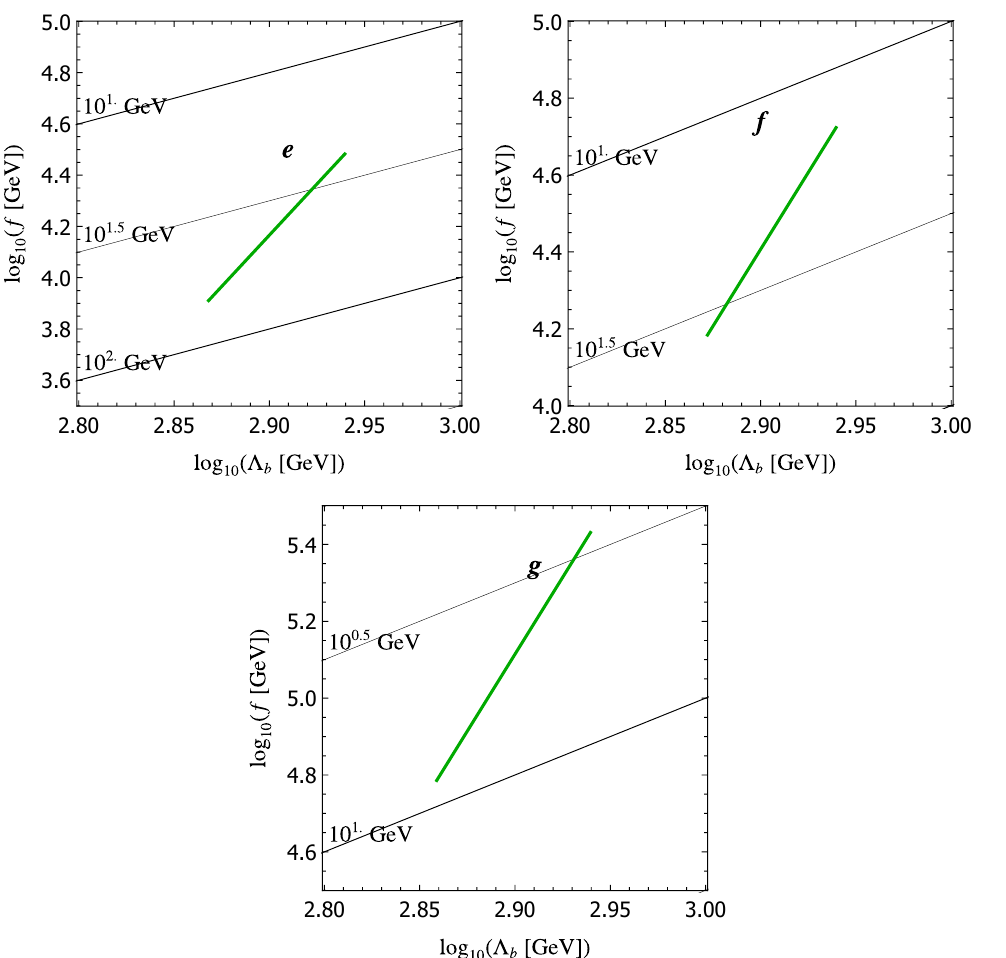
Figure 27 . Contours of m (cid:30) , as de(cid:12)ned in eq. (3.11), in the allowed range of f and (cid:3) b for the three benchmark points e , f , g in (cid:12)gure 5 corresponding to the case of self-stopping relaxion NOT during in(cid:13)ation discussed in section 3.2. e